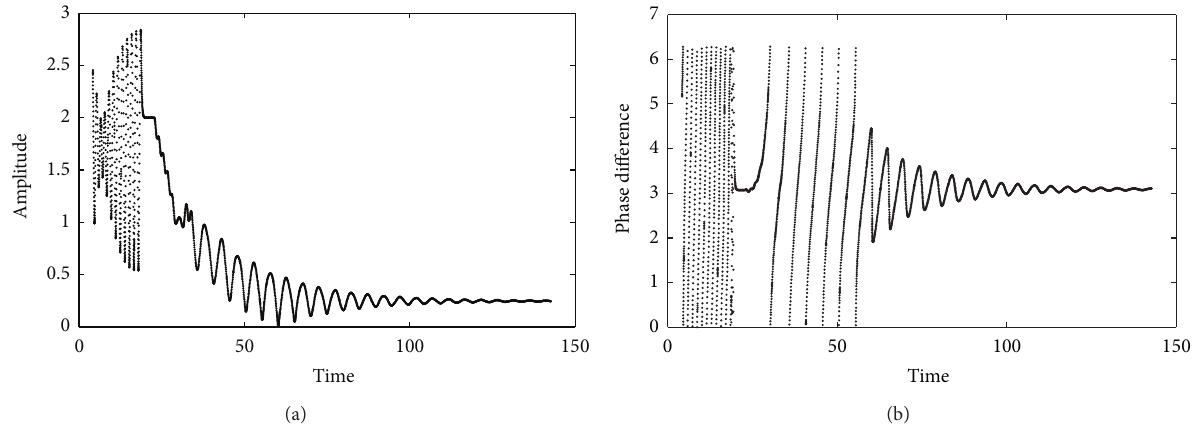
To diminish the error equations (10), the action of the controller is proposed